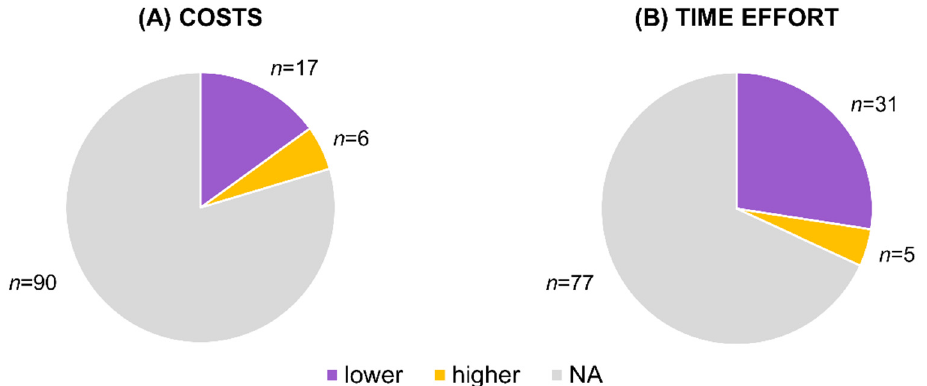
Figure 5. ( A ) The number of studies reporting lower or higher costs of noninvasive genetic assessment in comparison with another method and studies that did not make this comparison (NA = not assessed). ( B ) The number of studies reporting lower or higher time effort of noninvasive genetic assessment in comparison with to another method and studies that did not make this comparison (NA = not